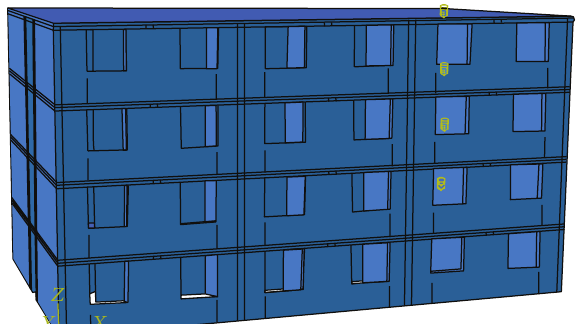
Figure 5: Model 3 with structural columns (1.2m).